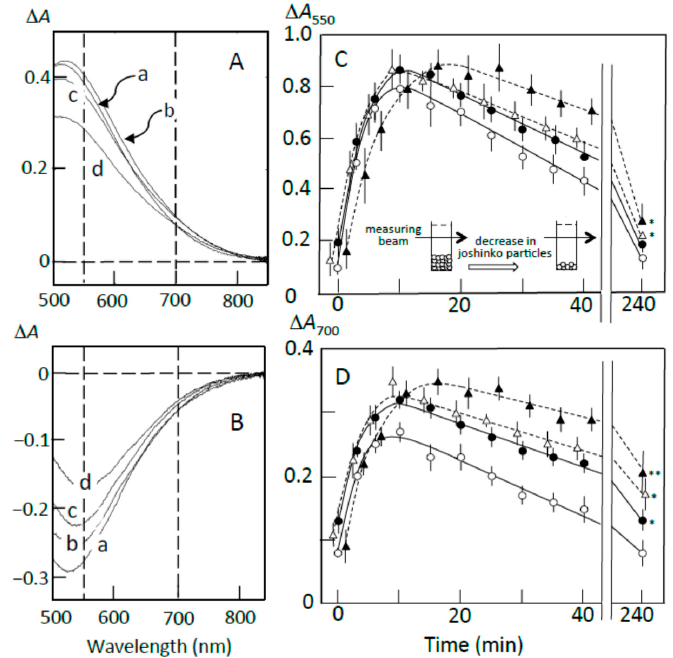
Figure 5. Pancreatin-induced starch digestion of the sediment. The sediment was prepared as described in Materials and Methods. ( A , B ) ∆ A spectra of 3 min minus 0 min and 40 min minus 20 min of incubation, respectively. ( a ) 0 μ L, ( b ) 3 μ L, ( c ) 6 μ L, ( d ) 10 μ L of the adzuki extract. ( C , D ) Time course of starch release from the sediment and digestion of the released starch measured at 550 and 700 nm, respectively. ( ○ ) 0 μ L, ( ● ) 3 μ L , ( ∆ ) 6 μ L, ( ▲ ) 10 μ L of the adzuki extract. Each data point is average with SD ( n = 3). * p < 0.05; ** p < 0.01.